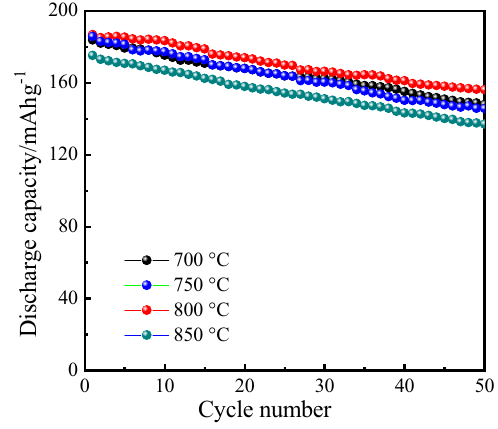
Figure 4: Cycling performance of LiNi 0.8 Co 0.15 Al 0.05 O 2 prepared at di ff erent calcination